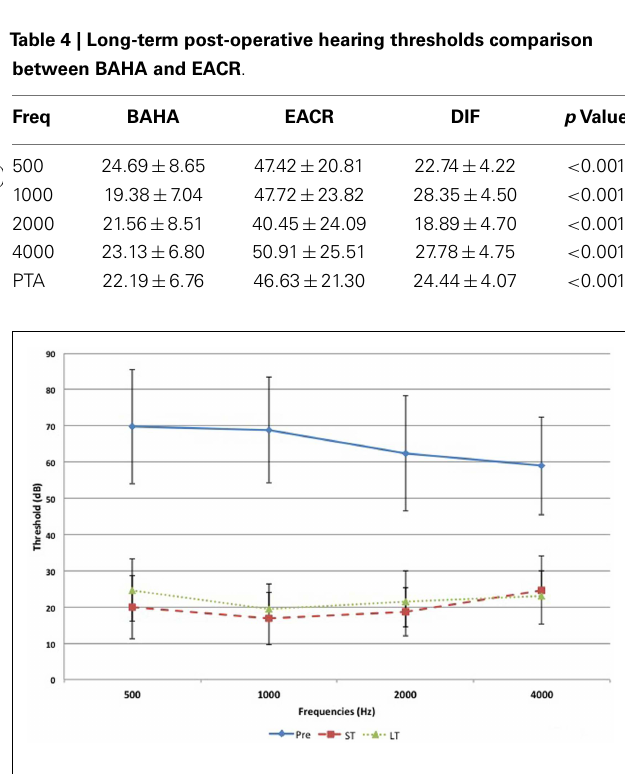
FIGURE 1 | Evolution of hearing threshold overtime for the BAHA group